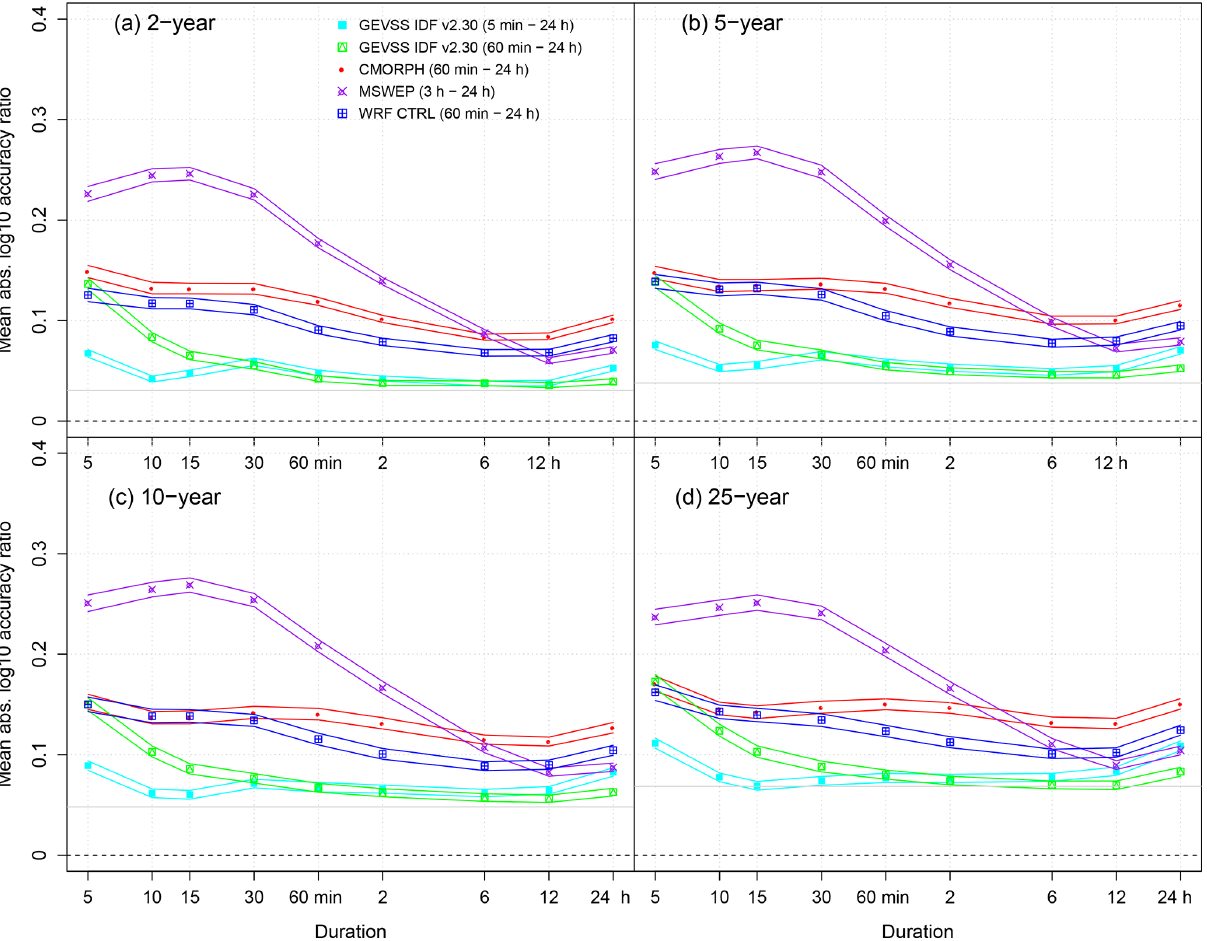
Figure 8. As in Fig. 7, but for MALAR. For reference, the horizontal gray line indicates the expected MALAR for empirical quantile estimates, based on 25-year samples (the median record length of TBRG station observations), from a true GEV (µ = 1 . 93 , σ = 0 . 64 , ξ = 0 . 10 ) distribution; parameters correspond to median estimates at the 488 IDF curve TBRG stations.